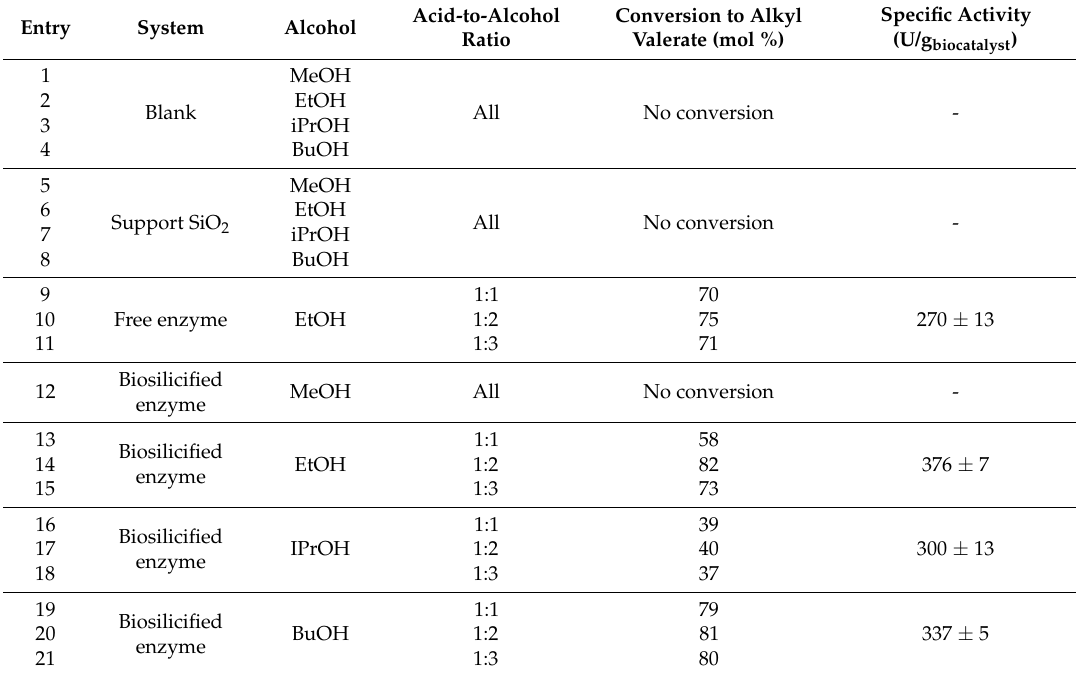
Table 7. MW-assisted esterification of valeric acid using different alcohols (MeOH, EtOH, iPrOH, BuOH) and different acid-to-alcohol molar